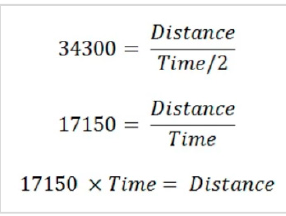
Figure 11. Distance calculation for ultrasonic sensor [36].